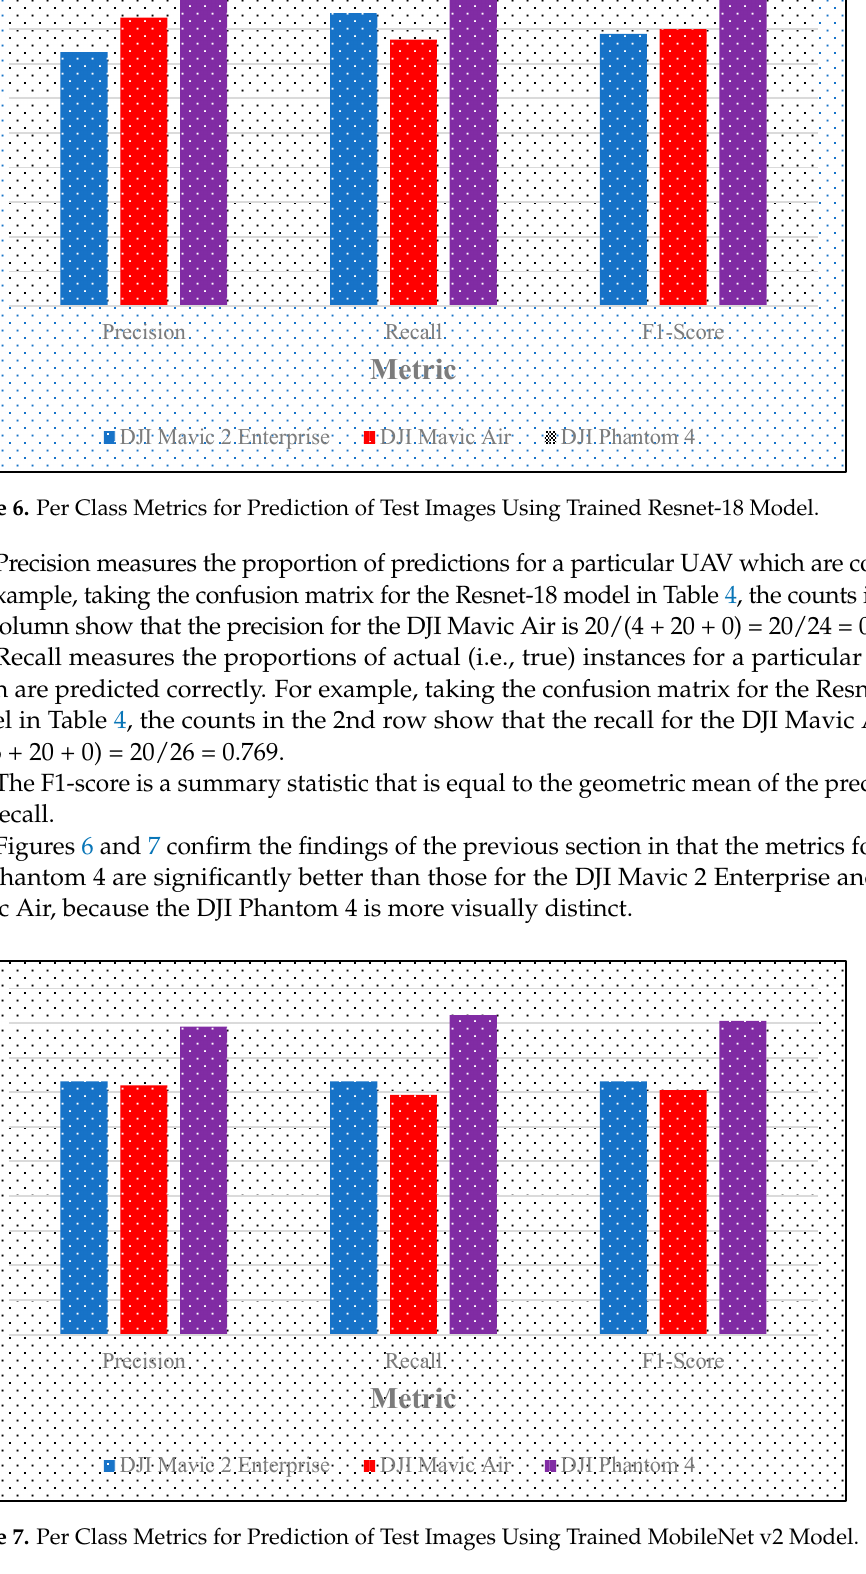
Figure 7. Per Class Metrics for Prediction of Test Images Using Trained MobileNet v2 Model.